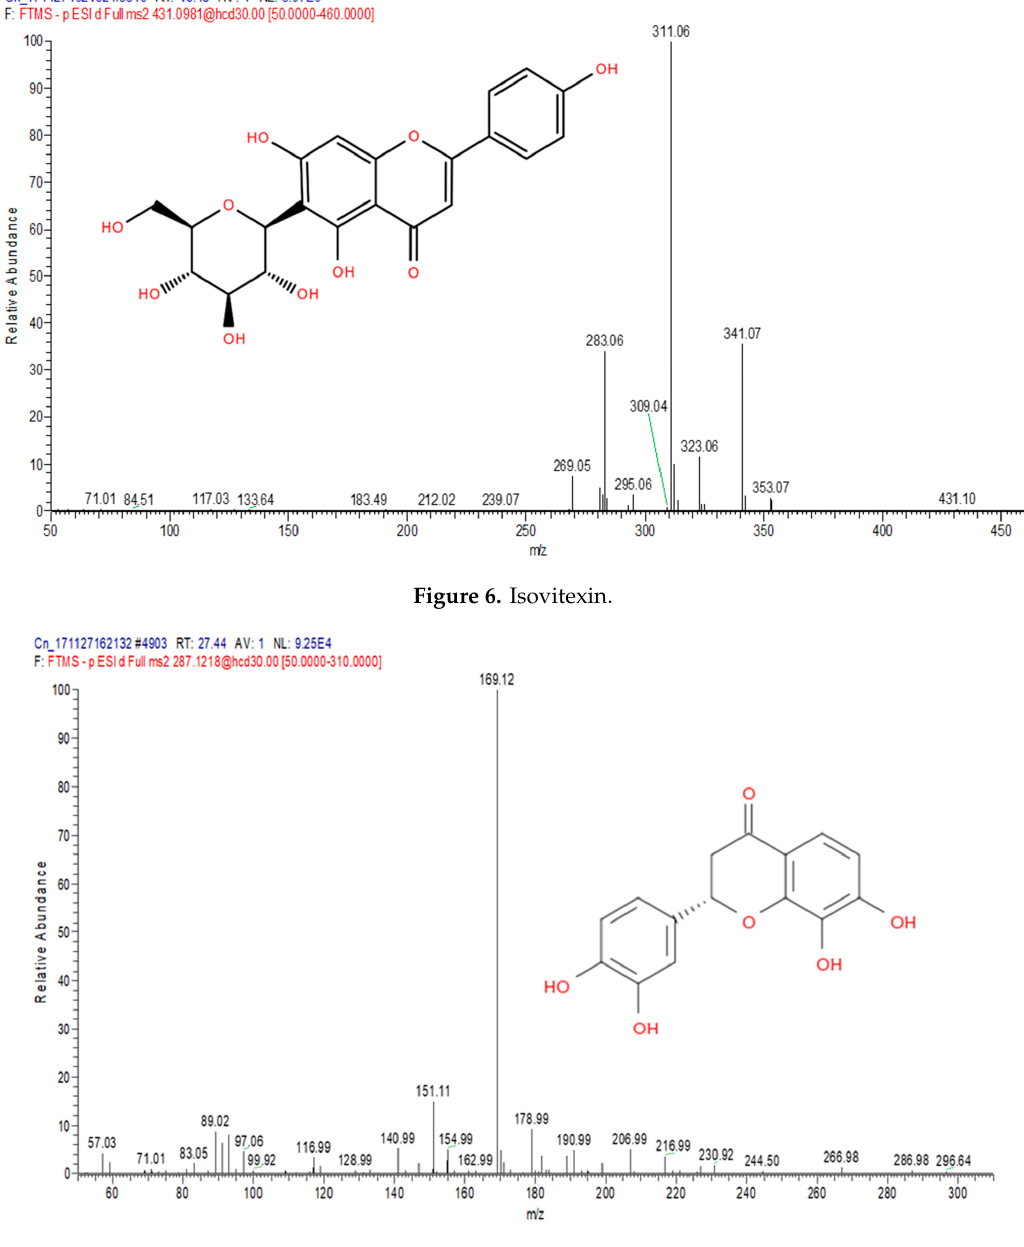
Figure 7. Isookanin.